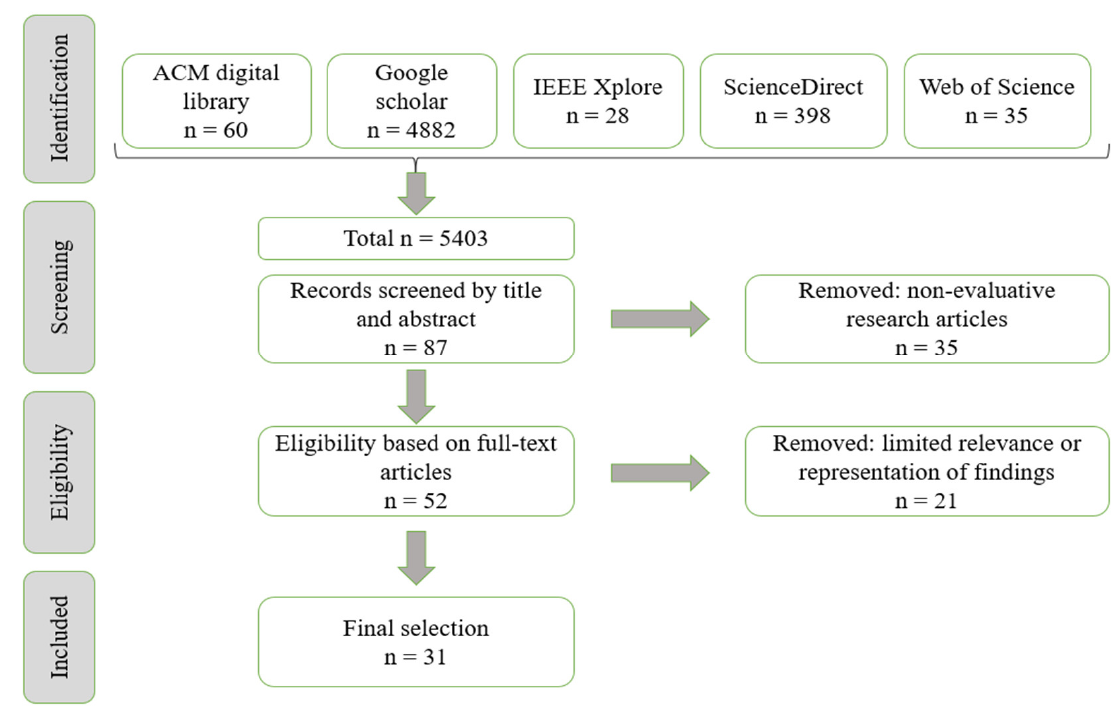
Figure 1. PRISMA flow chart depicting the article search process.